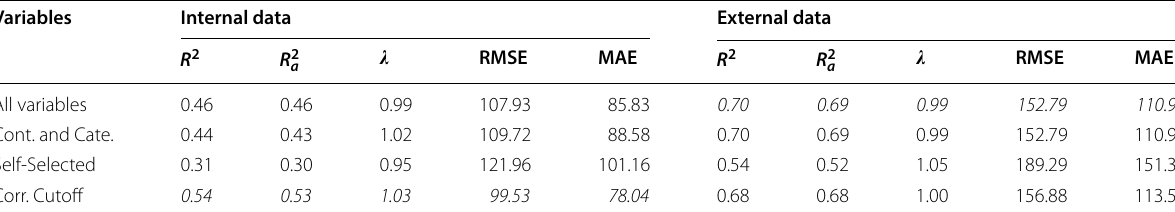
Table 4 SPCA models’ R 2 , R 2 a , (cid:31) , RMSE, and MAE values.